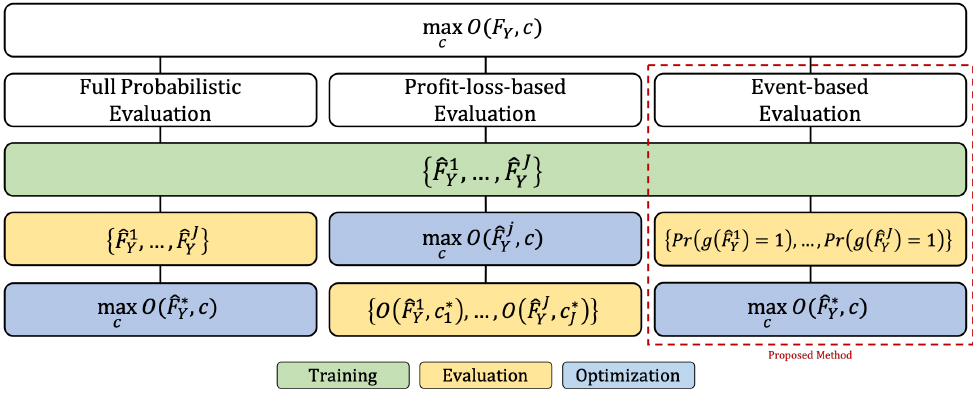
Figure 1. Considered Forecast Evaluation